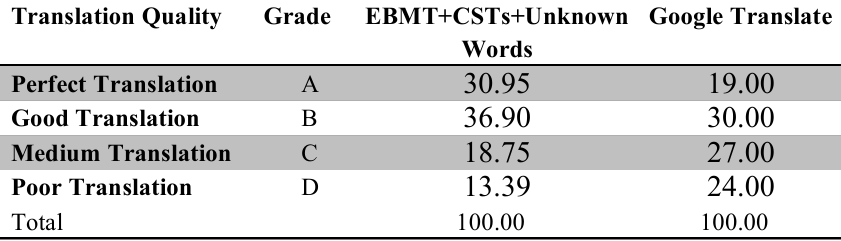
Table 11. Human Evaluation of Unknown words using same test-set Translation